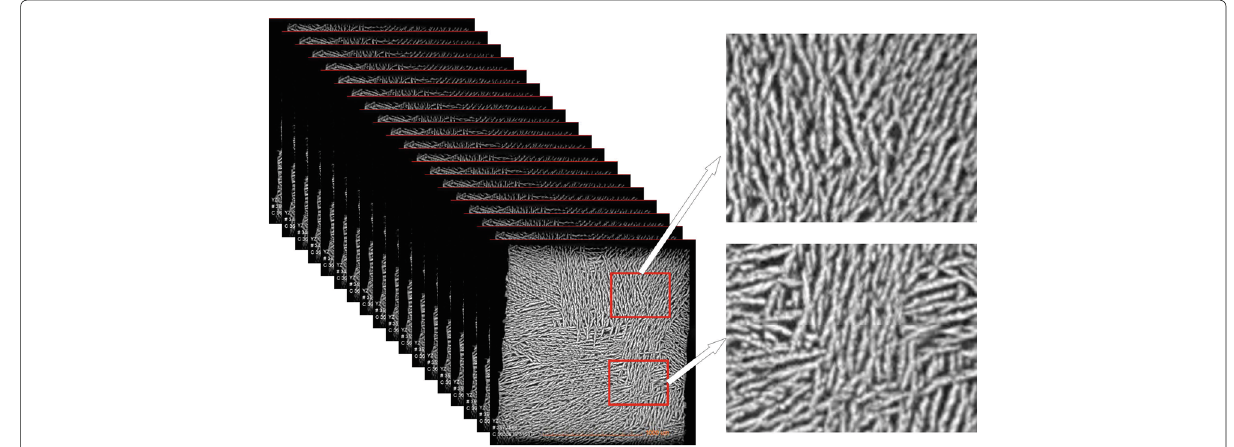
Fig. 1 Image sections of 3d Al − La